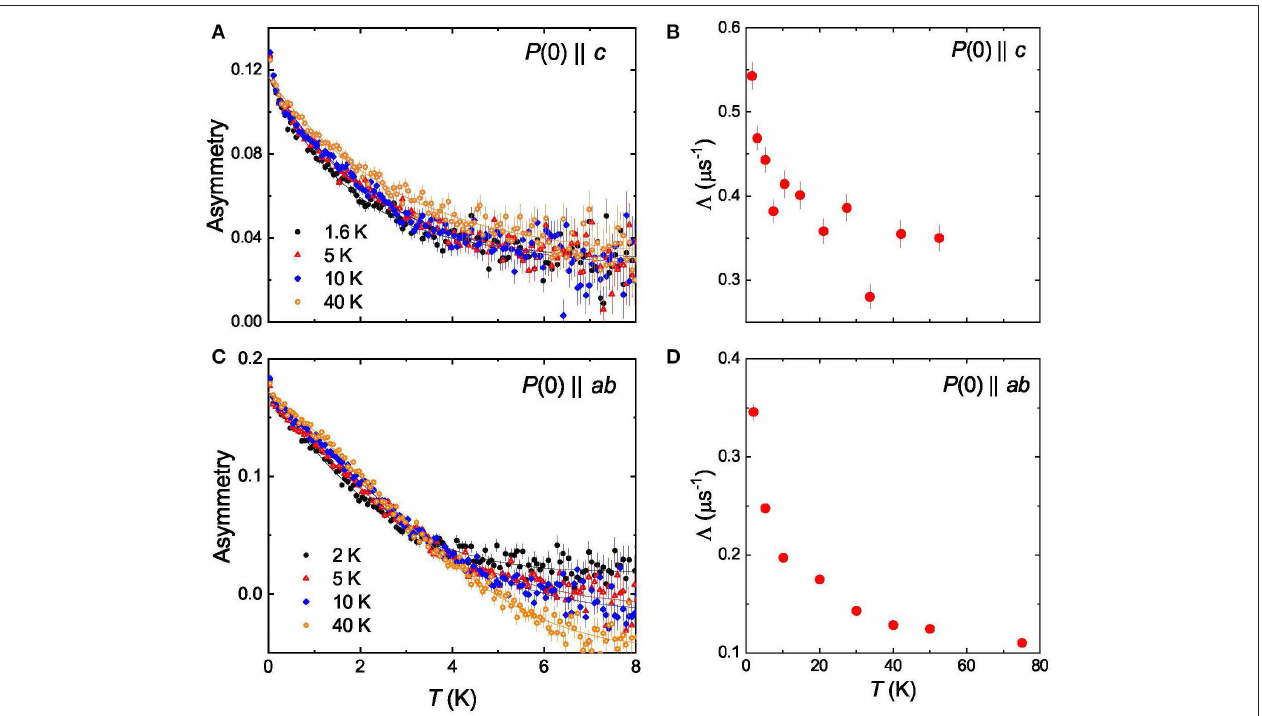
FIGURE 2 | (A) ZF- µ SR time-spectra of NdFeAsO 0.65 F 0.35 measured at T 1.6, 5, 10, and 40 K with the initial muon-spin polarization P (0) applied parallel to the = crystallographic c axis. (B) The temperature evolution of the exponential relaxation rate 3 obtained from the fit of Equation (1) to P (0) − ab set of experiments and T as in (A,B) , but for P (0) 2.0, 5, 10, and 40 k =